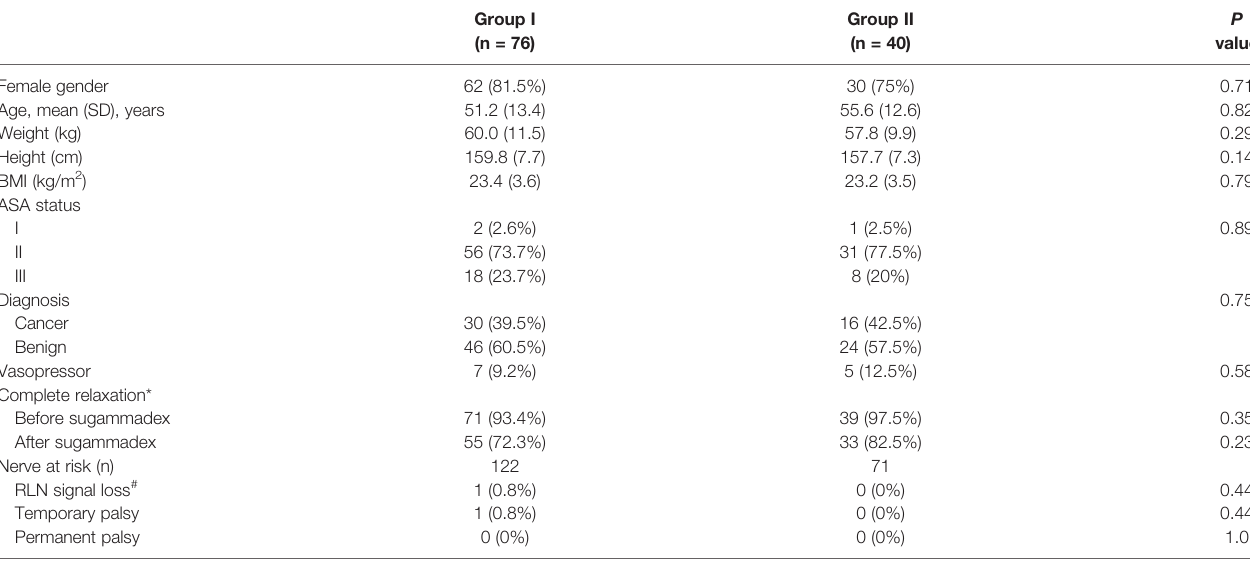
TABLE 2 | Patient characteristics of 116 patients receiving monitored